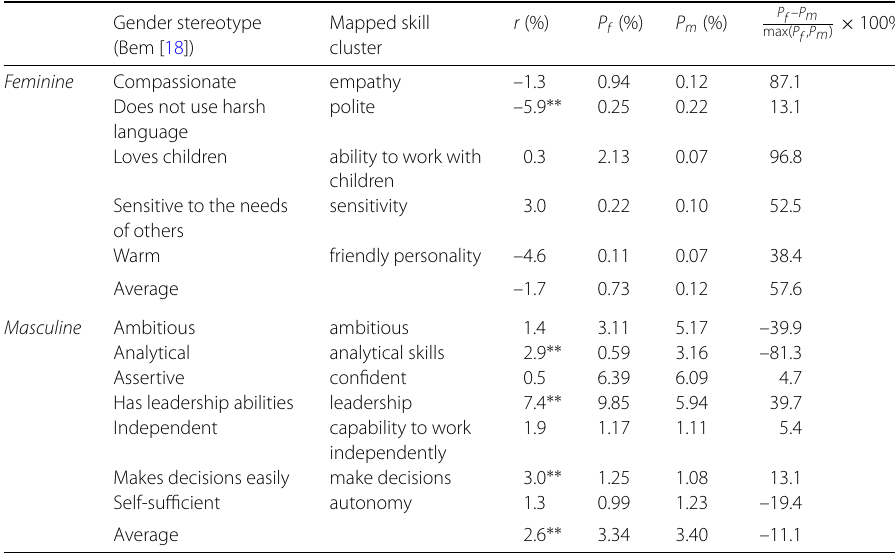
Table 5 OLS regression results predicting the proportion of women using soft skill clusters as predictors Gender stereotype Mapped skill (Bem [18])